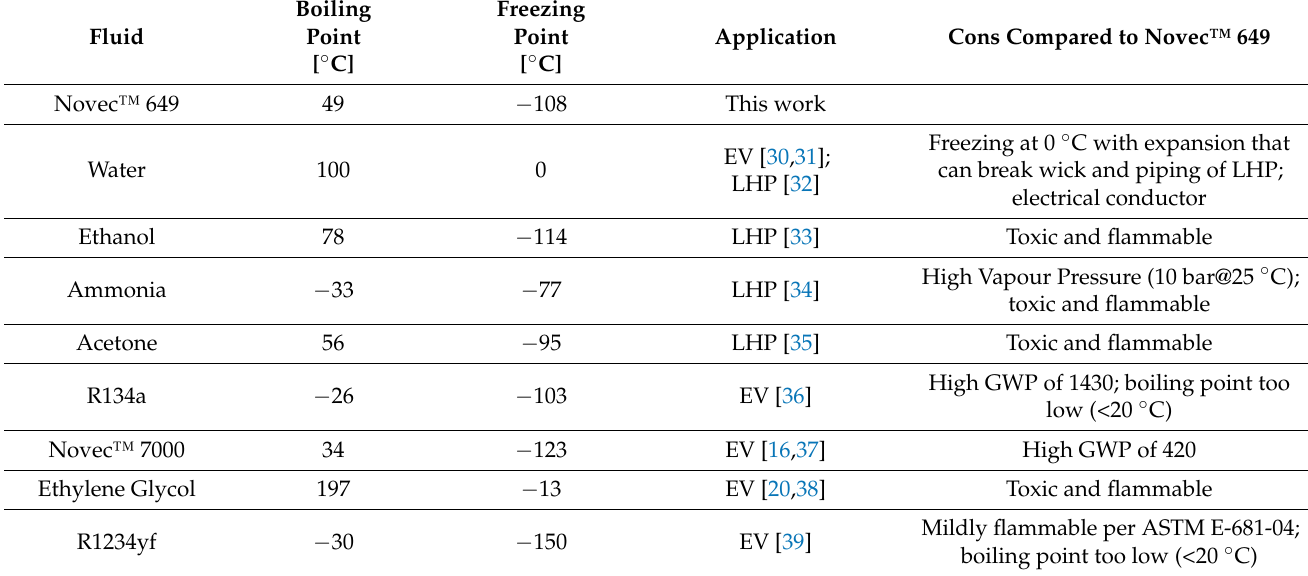
Table 4. How Novec™ 649 compares against other standard LHP and automotive working